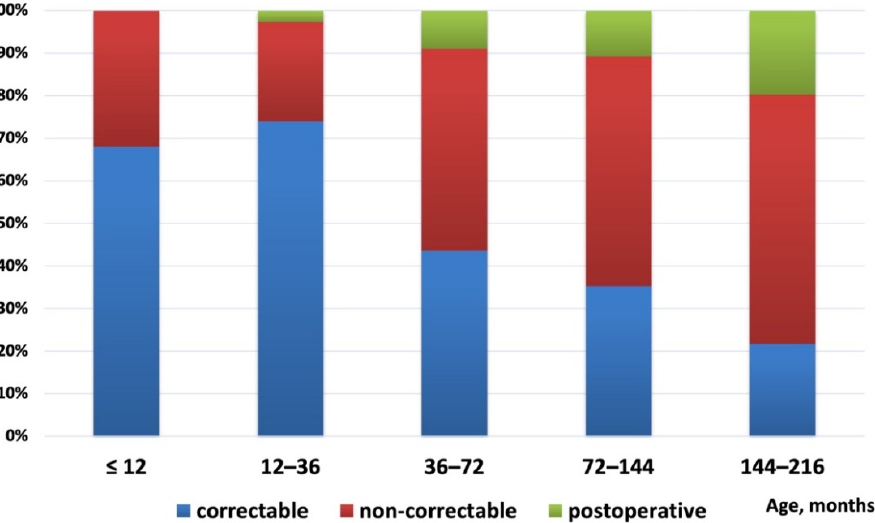
Figure 1. Distribution of defects correction status with patients age at the diagnostic right heart catheterization.